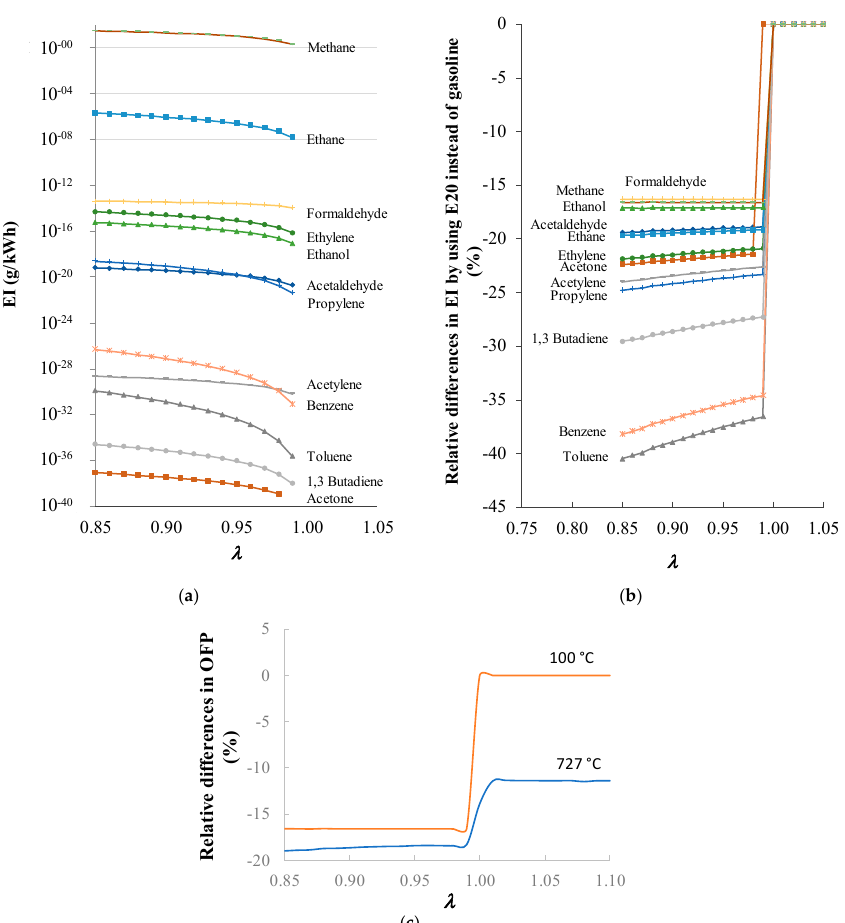
Figure 9. ( a ) Estimated emission indexes for the most relevant volatile organic compounds (VOCs) for gasoline and E20 fueled vehicles. Relative differences of using E20 instead of gasoline in ( b ) emission indexes and ( c ) ozone formation potential.